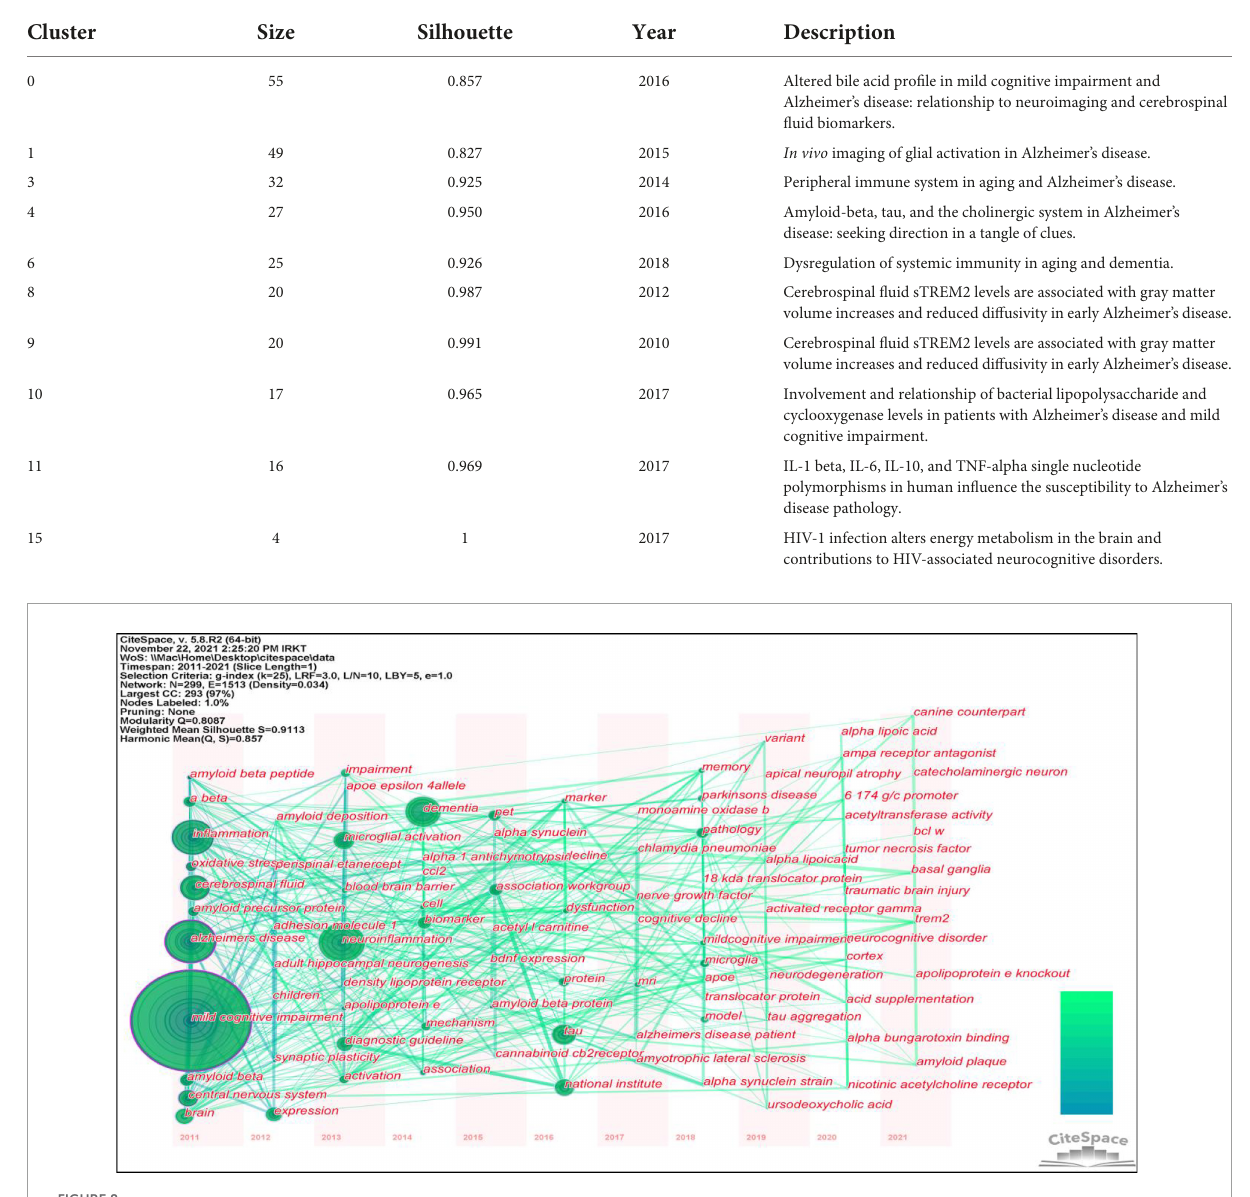
Figure 8 plots the keywords throughout 2011–2021, showing the changes in the core research areas in the past decade. The position of the keyword circles represents the year in which the keyword first appeared, and the lines between circles represent the connections between each keyword.